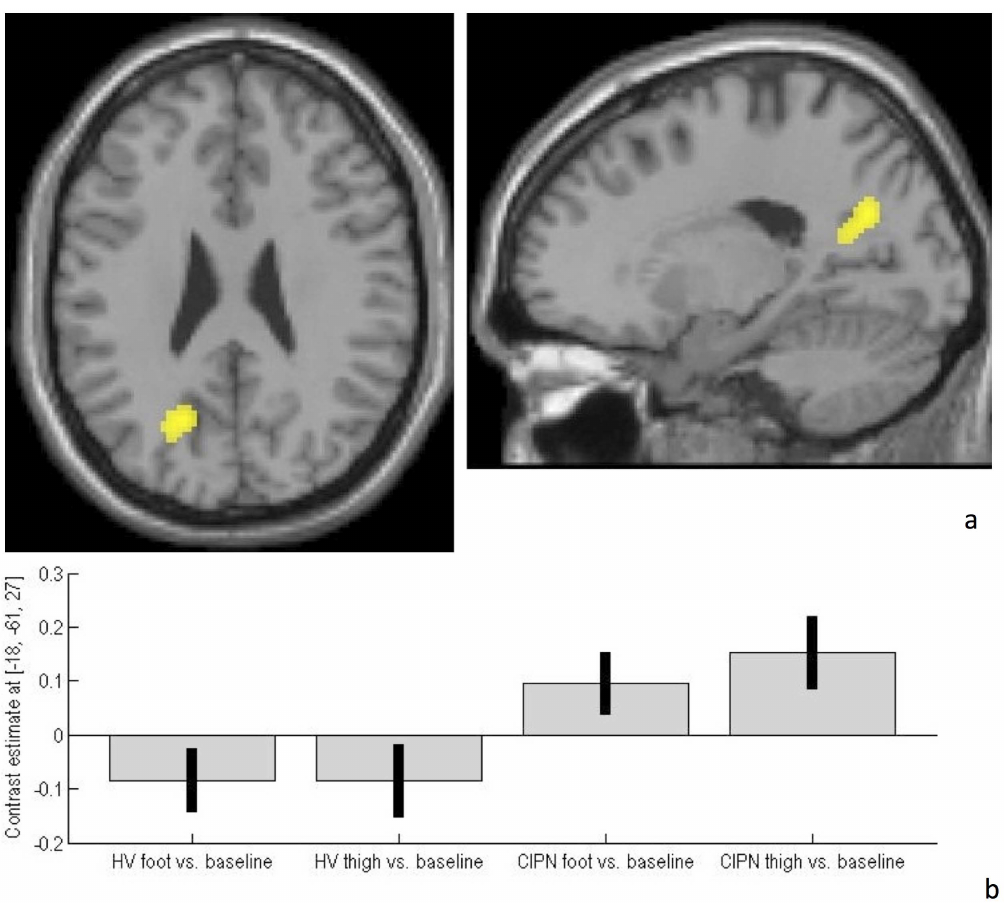
Figure 2. CIPN-myeloma patients demonstrated a0 hyper-activation of precuneus during heat-pain stimulation, compared with healthy volunteers. Functional imaging data are shown overlaid on both axial (z=27 mm) and sagittal (x= 2 18 mm) slices through a canonical single-subject T1-weighted image. For display purposes, the statistical threshold is p , 0.001, uncorrected, at the voxel-level. b) Contrast estimates and 90% CI at co-ordinate 2 18, 2 61, 27 for both healthy volunteer and CIPN-myeloma patient groups.